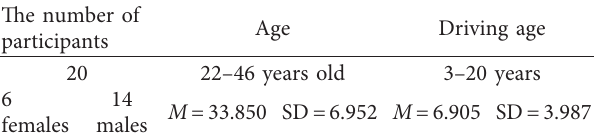
Table 2: Basic information of the